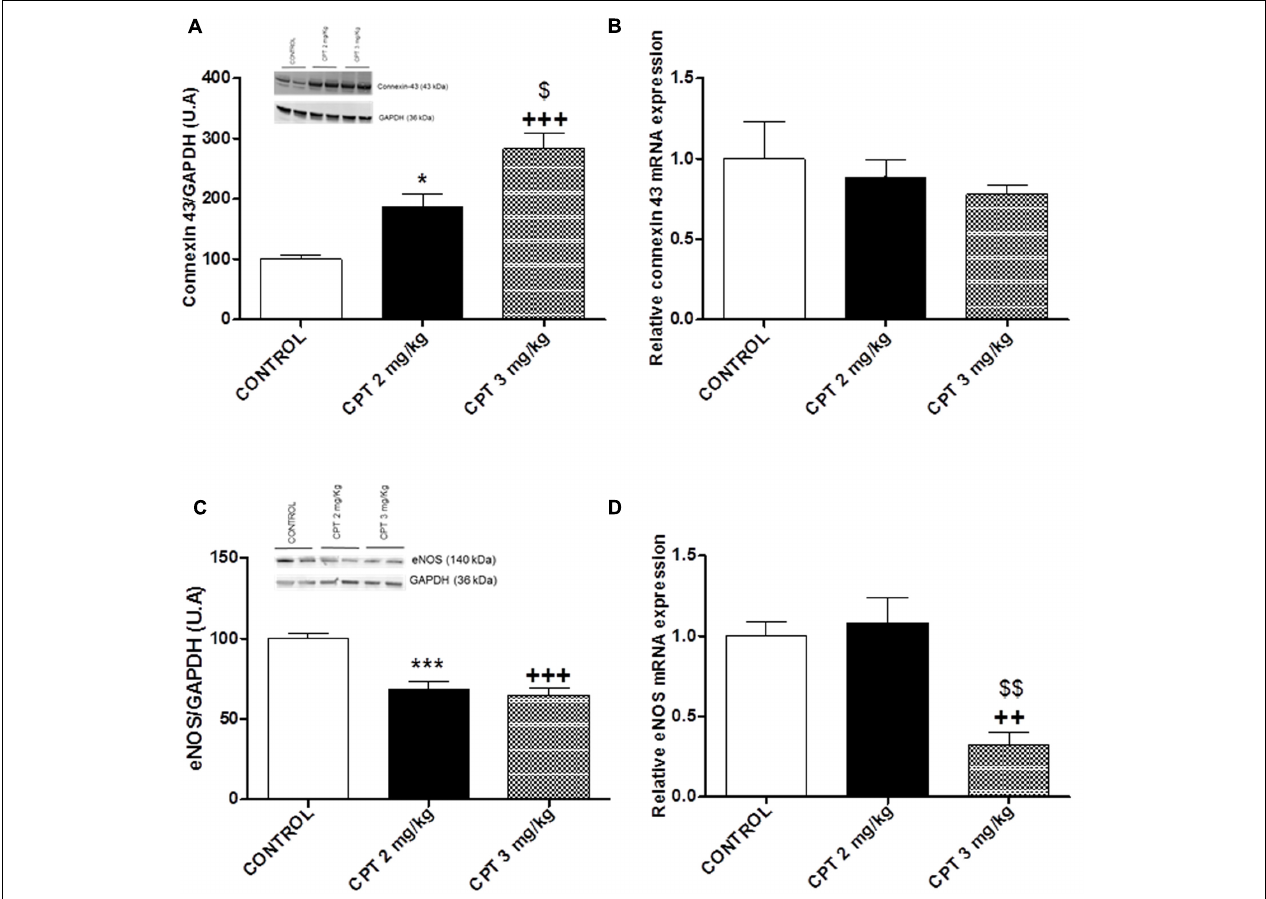
FIGURE 6 | (A) Representative immunoblots for connexin-43 protein expression in whole cardiac left ventricle. Diagram bars show the results of densitometric analysis of connexin-43 in whole cardiac left ventricle. Homogenized samples from heart show essentially the connexin-43 in its phosphorylated form (strongest bands for the quantification) (B) Quantitative analysis of connexin-43 mRNA levels in whole cardiac left ventricle. (C) Representative immunoblots for eNOS protein expression. Diagram bars show the results of densitometric analysis of eNOS in whole cardiac left ventricle. (D) Quantitative analysis of eNOS mRNA levels in whole cardiac left ventricle Data are presented as means ± SEM of observations obtained for 5–8 tissue samples from 5 to 8 animals per treatment. A one-way ANOVA followed by Bonferroni/Dunn post hoc test was used for statistical analysis ( ∗ P < 0.05, CPT 2 mg/kg vs. control, ∗∗∗ P < 0.001, CPT 2 mg/kg vs. control, +++ P < 0.001, CPT 3 mg/kg vs. control, $ P < 0.05, CPT 3 mg/kg vs. CPT 2 mg/Kg, $$ P < 0.01, CPT 3 mg/kg vs. CPT 2